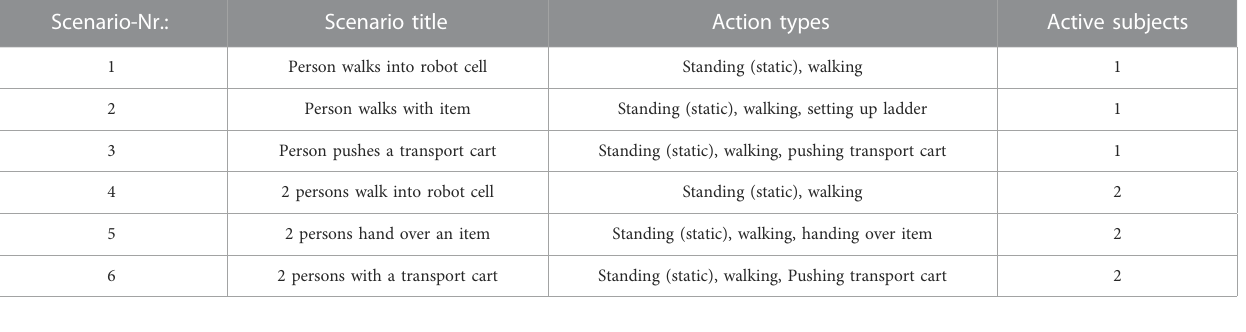
TABLE 1 Test scenarios to investigate the performance of the annotation tool. Scenario-Nr.: